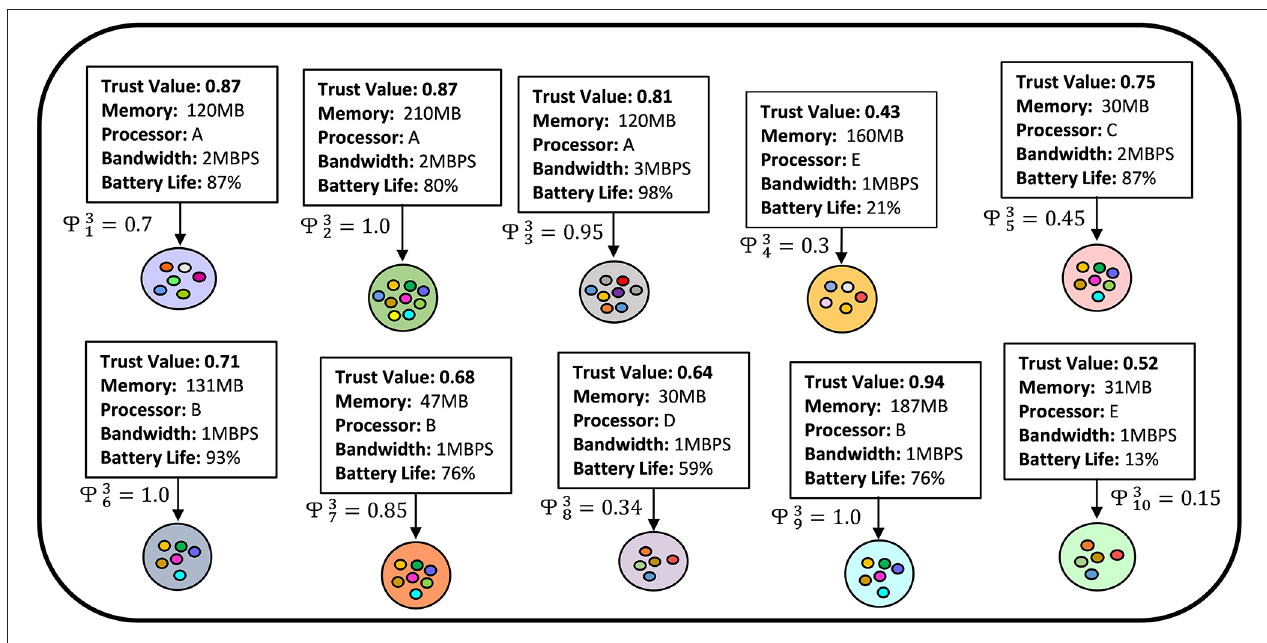
FIGURE 3 | Partial amounts of work to be performed by the selected clients.